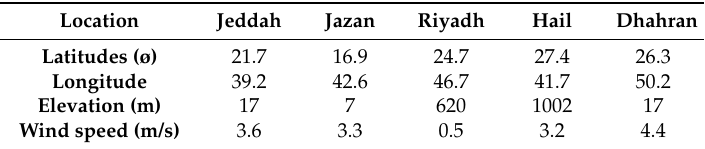
Table 3. Geographic data of study related cities.